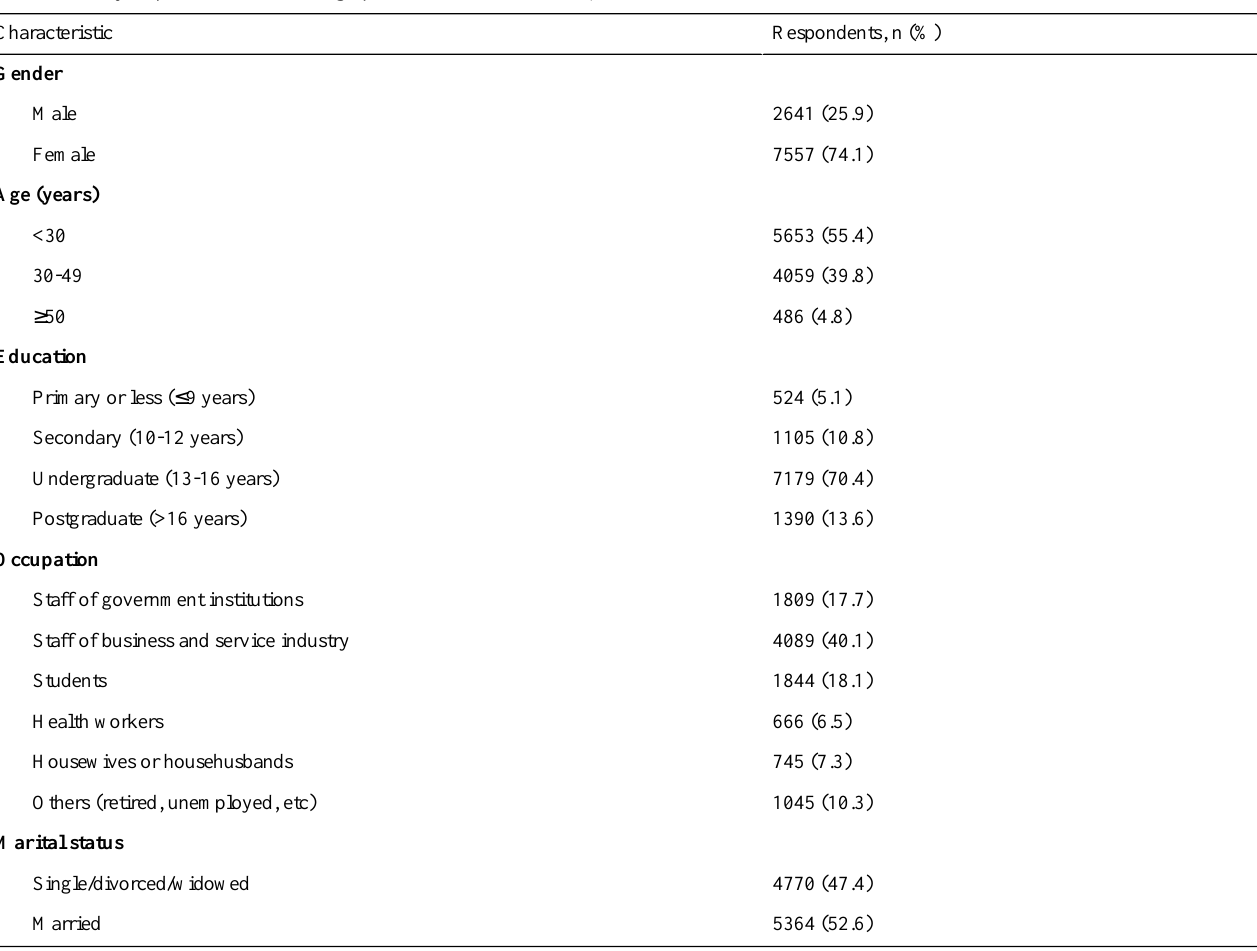
Table 1. Survey respondents’sociodemographic characteristics